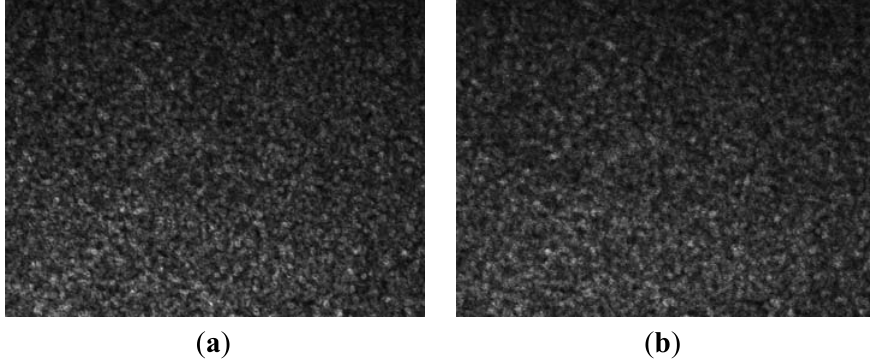
 f  . The pictures (cid:0)